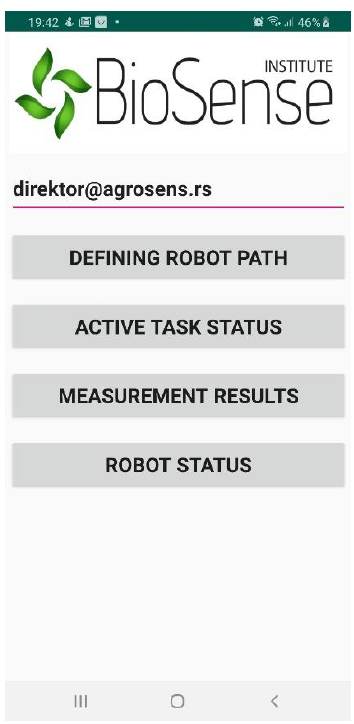
Figure 3. The main menu of the RoboSense smartphone application.